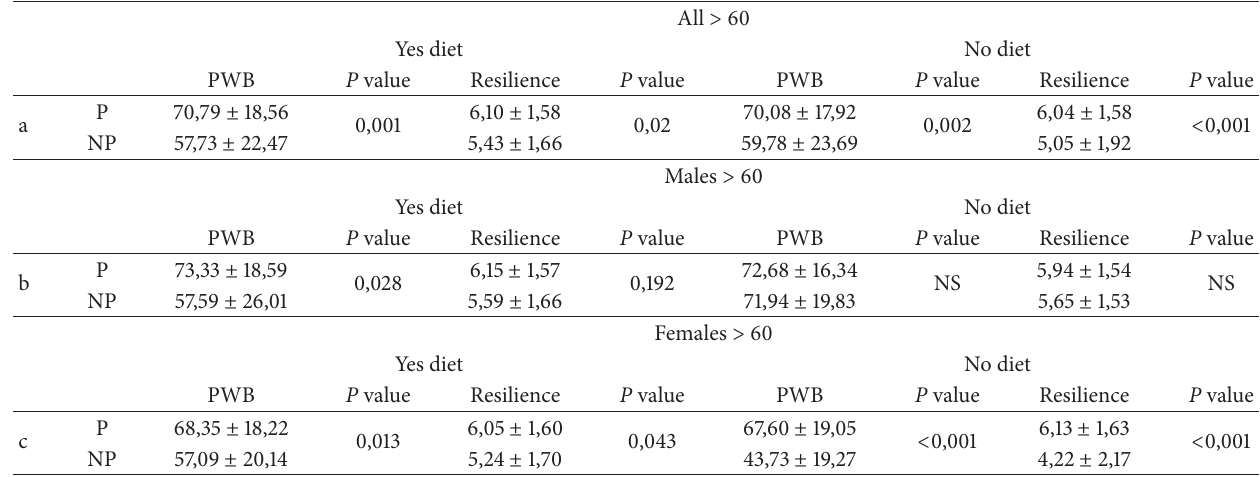
Table 5: Panel a : BMI, PWB, and resilience in > 60 subjects following or nonfollowing a diet in relation to participation to cultural and social activities. Results are reported as mean ± SD. 𝑃 value has been calculated by Student’s 𝑡 -test between each two groups. Panel b : BMI, PWB, and resilience in females > 60 following or nonfollowing a diet in relation to participation in cultural and social activities. Results are reported as mean ± SD. 𝑃 value has been calculated by Student’s 𝑡 -test between each two groups. Panel c : BMI, PWB, and resilience in males > 60 following or nonfollowing a diet in relation to participation in cultural and social activities. Results are reported as mean ± SD. 𝑃 value has been calculated by Student’s 𝑡 -test between each two